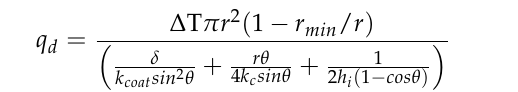
Figure 3. Schematic diagram of thermal resistance network of a single droplet.